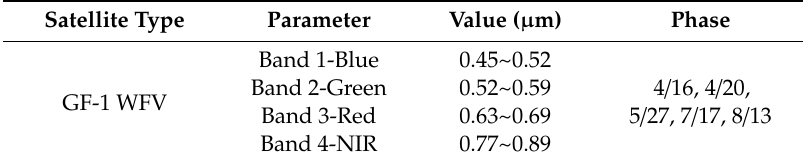
Table 10. Description of GF-1 data used in the northwest of Wuwei City.